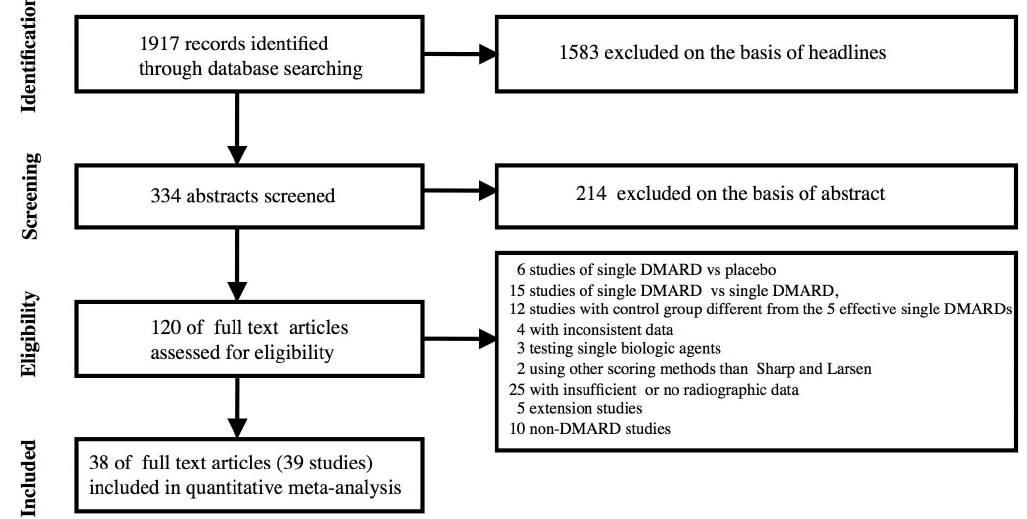
Figure 1. Flow diagram of literature search.